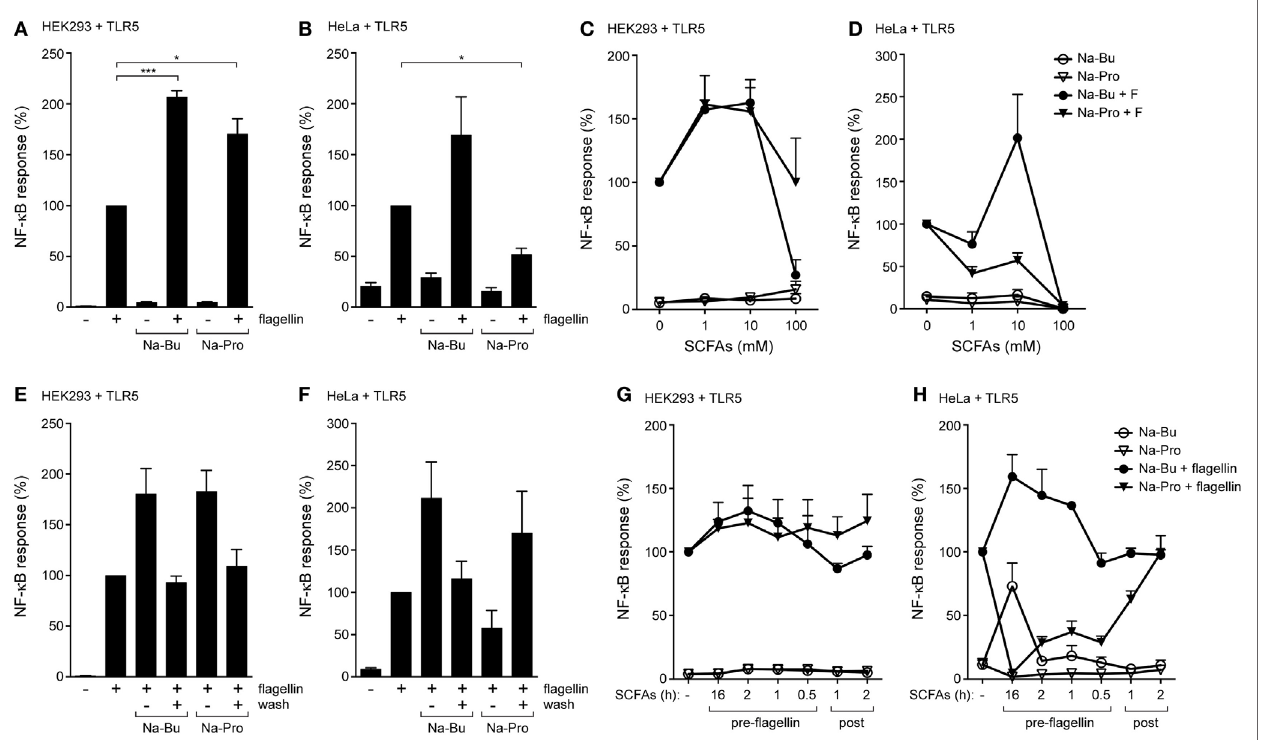
FigUre 1 | scFas enhance Tlr5-nF- κ B responses in epithelial cells. (a,B) TLR5-NF- κ B assay in HEK293 or HeLa 57A expressing TLR5 and a NF- κ B- luciferase reporter. Cells were incubated with 10 mM sodium butyrate (Na-Bu) or sodium propionate (Na-Pro) for 30 min followed by stimulation with Salmonella enteriditis flagellin for 5 h. (c,D) TLR5-NF- κ B assay in HEK293 or HeLa 57A cells as described above with SCFA concentrations ranging from 0 to 100 mM. (e,F) Reversibility of the immunomodulatory effect of SCFAs. TLR5-NF- κ B assay in HEK293 or HeLa 57A cells incubated with 10 mM Na-Bu or Na-Pro for 30 min after which SCFAs of selected groups were removed by washing. (g,h) TLR5-NF- κ B assay to investigate pre- and post-incubation effects of SCFAs. Na-Bu or Na-Pro was added to HEK293 or HeLa 57A cells 16 h–30 min prior or 1–2 h after addition of flagellin. Bars depict mean and SEM of three independent experiments. p < 0.05 (*), p < 0.01 (**), p < 0.005